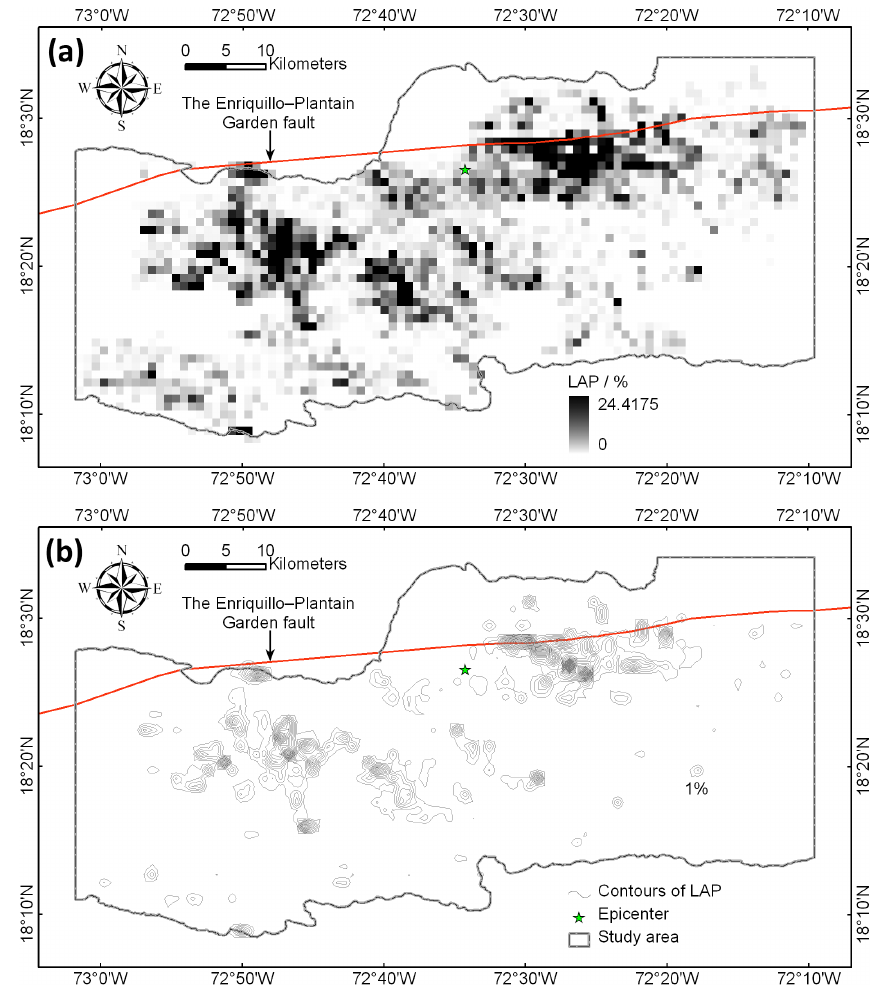
Figure 12. Distribution maps of landslide area percentage of the study area: (a) grid map and (b) contour map.